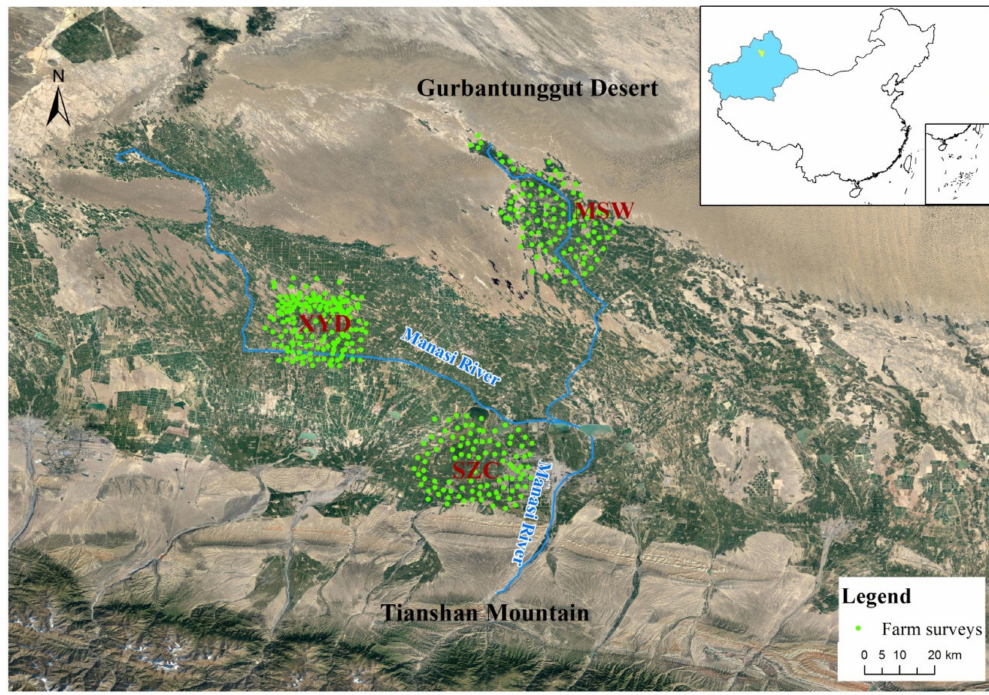
Figure 1. Satellite map of the study site in Xinjiang,